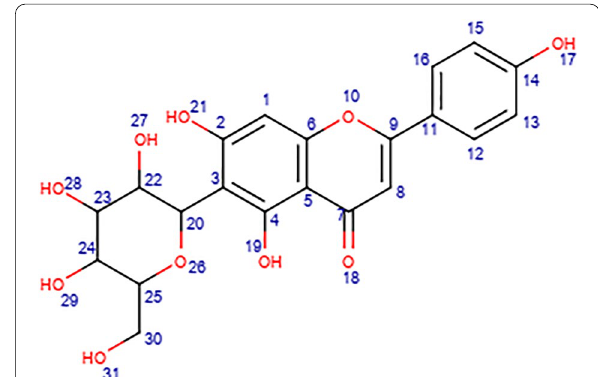
Fig. 8 Mapped structure of